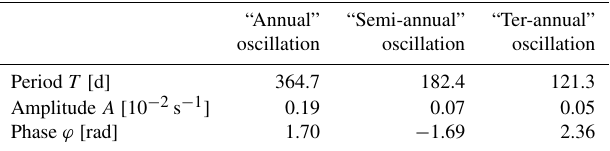
Table 1. Period, amplitude, and phase of the three oscilla- tions which explain the variability of the daily OH*-equivalent BV frequency values (averaged over all years) best. They os- cillate around a constant value of 2 . 32 × 10 − 2 s − 1 . The OH*- equivalent BV frequency [s − 1 ] can be estimated by 2 . 32 × 10 − 2 +